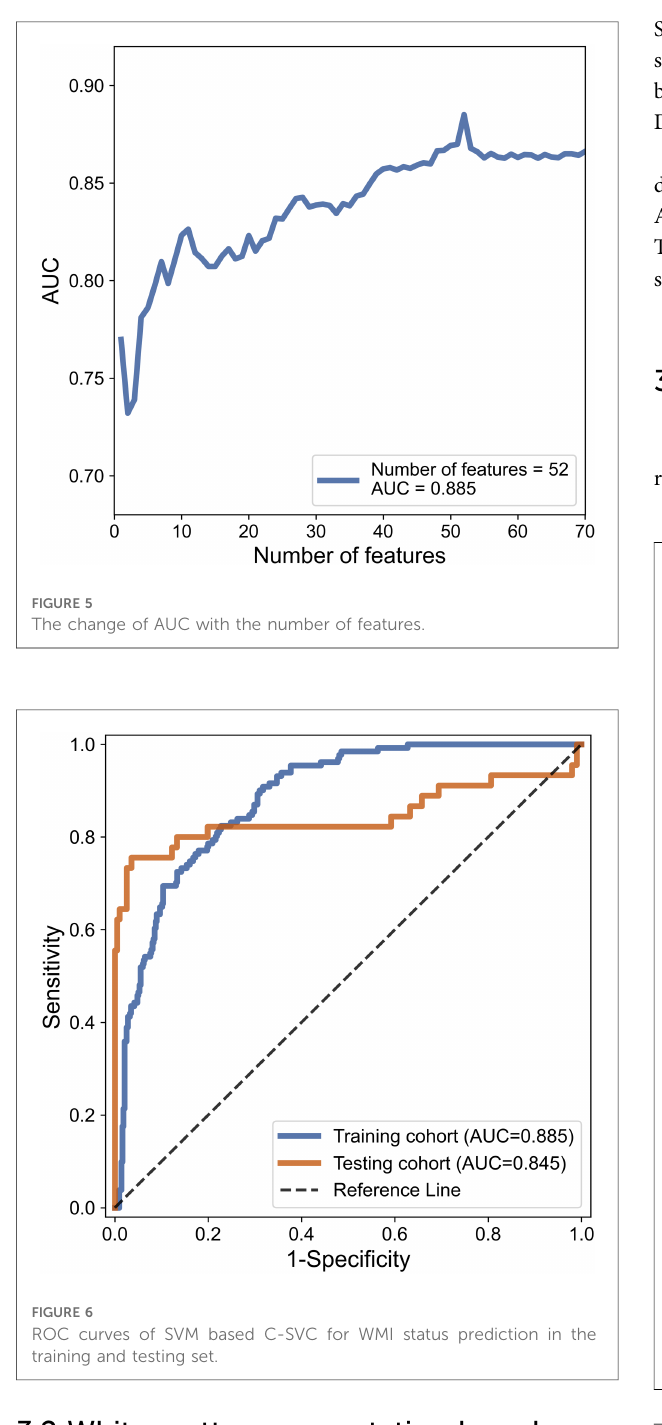
TABLE 2 The corresponding quantitative indexes for WMI status prediction in the training and testing